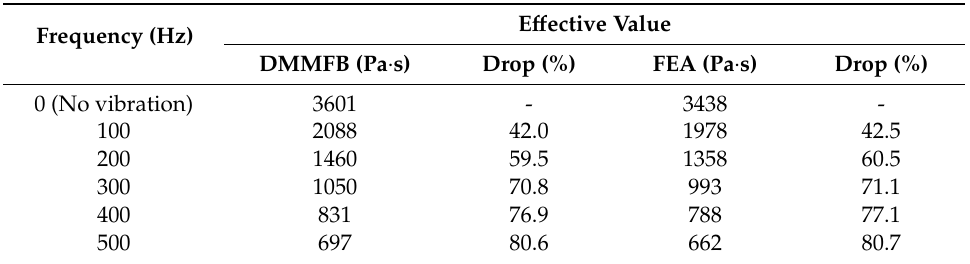
Table 11. Effective value of the apparent viscosity without and with 0.35 g vibration applied at different frequencies.